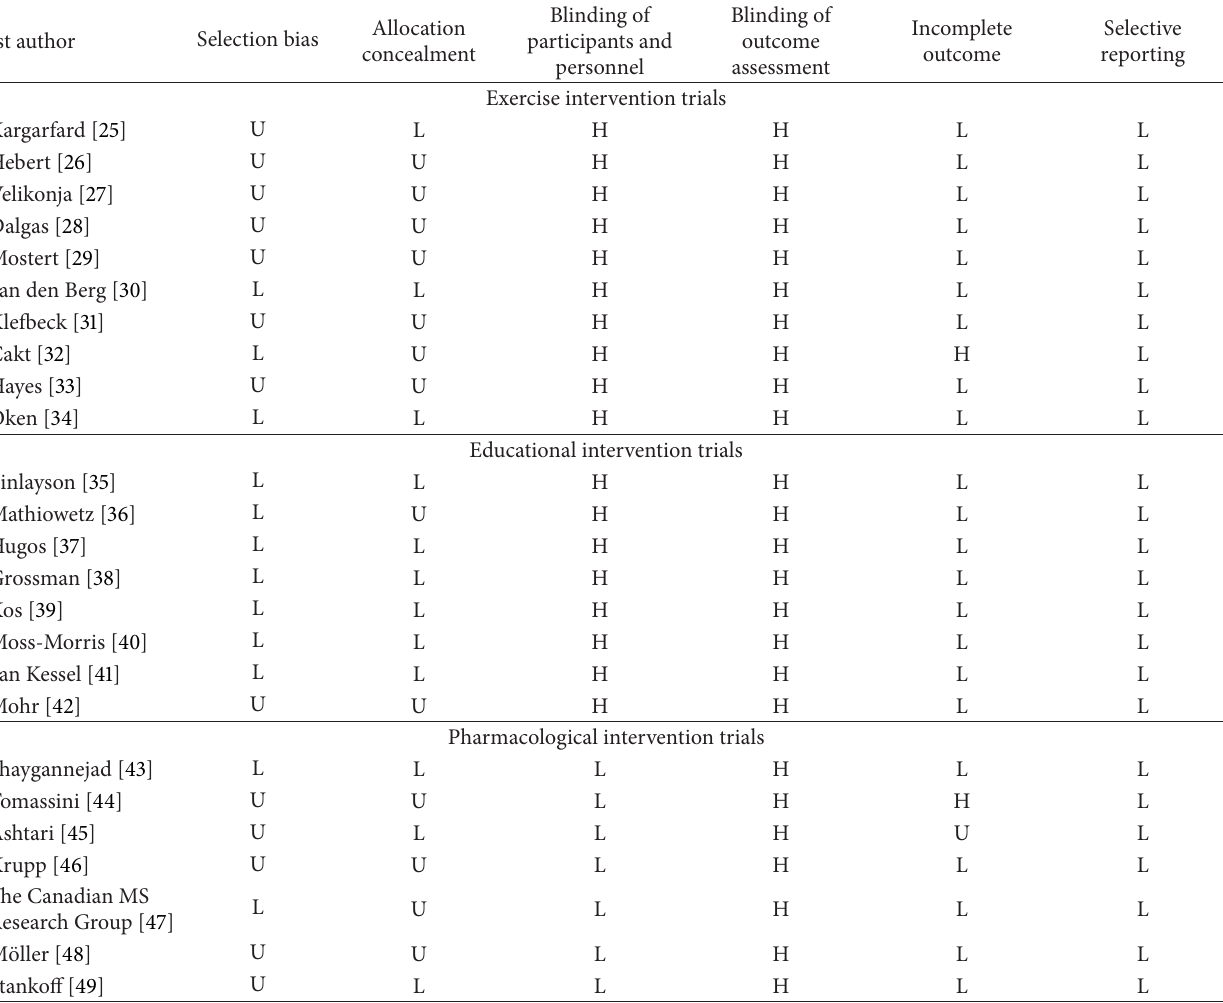
Table 4: Table of risk of bias